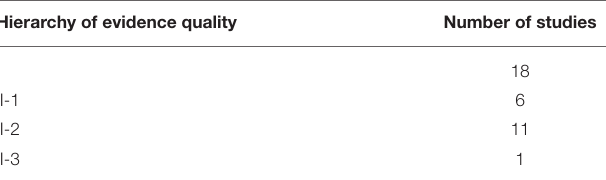
TABLE 3 | Methodological quality assessment of all studies included in this article. Hierarchy of evidence quality Number of